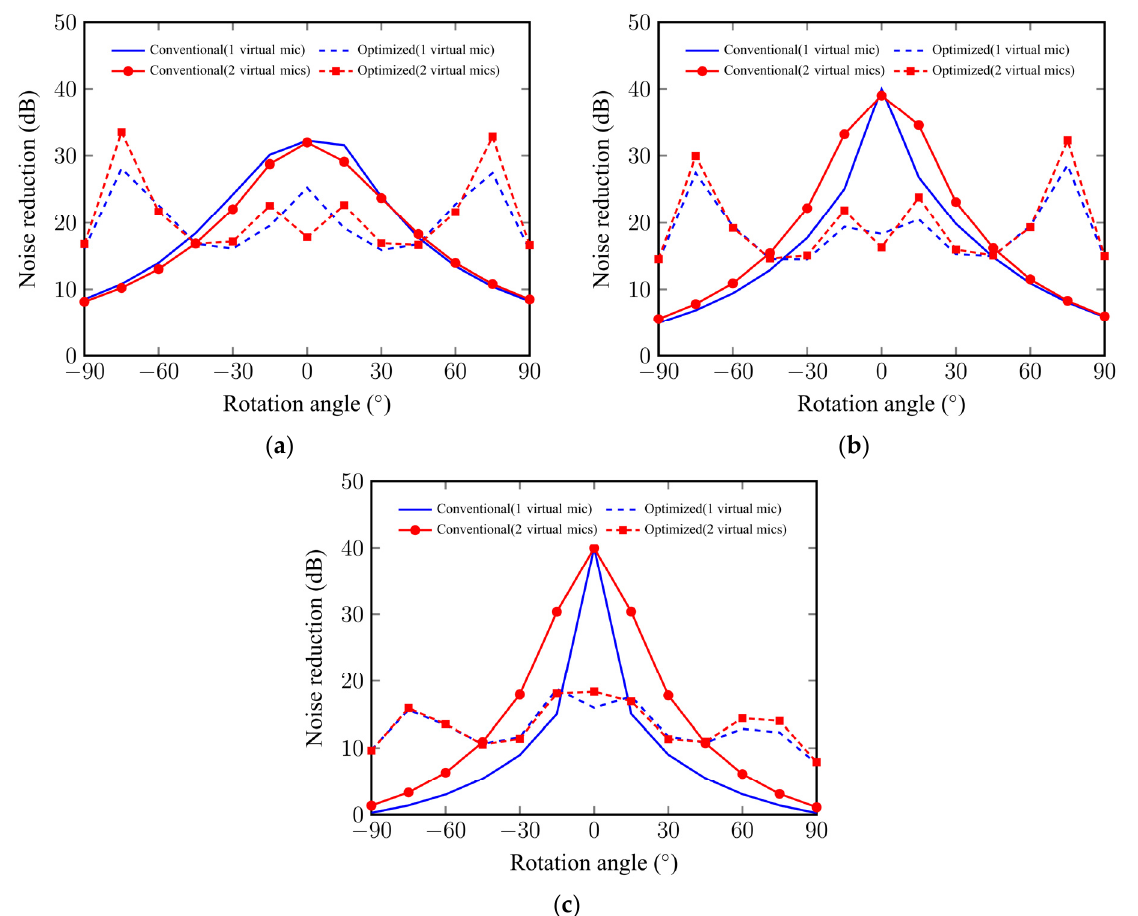
Figure 12. Noise attenuation when head rotates with single virtual microphone or two virtual microphones ( a ) 125 Hz, ( b ) 250 Hz and ( c ) 500 Hz.